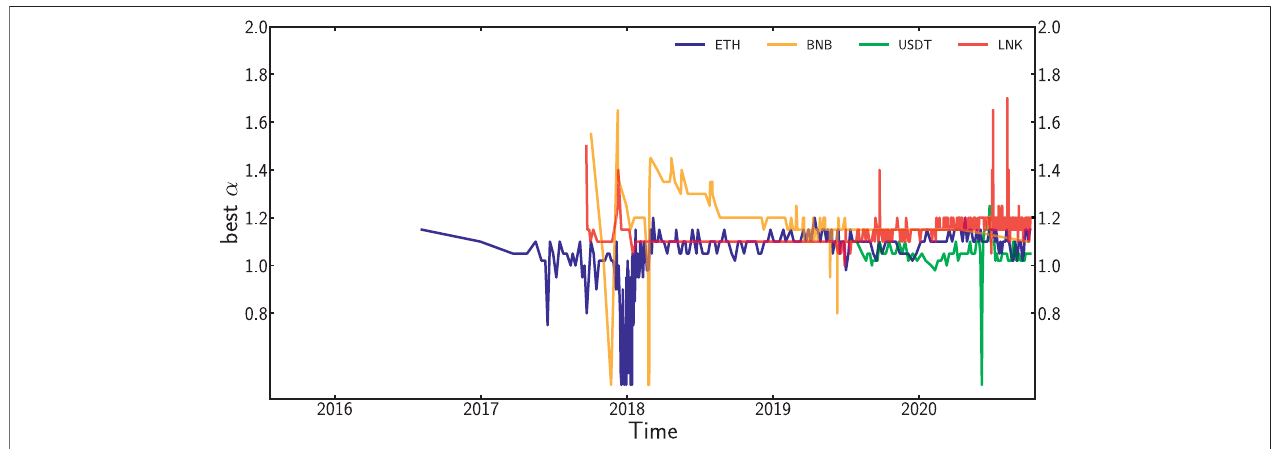
FIGURE 10 | (A) : evolution of best fi t α (cumulative) for preferential attachment throughout time. (B) : evolution of best fi t α for preferential attachment computed individually and in isolation for every time windows.